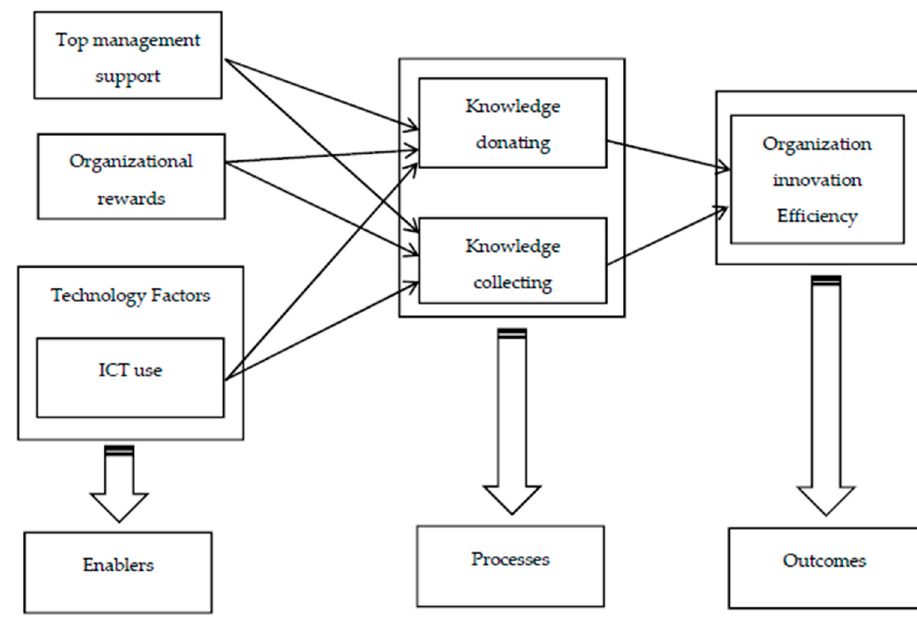
Figure 1. Research